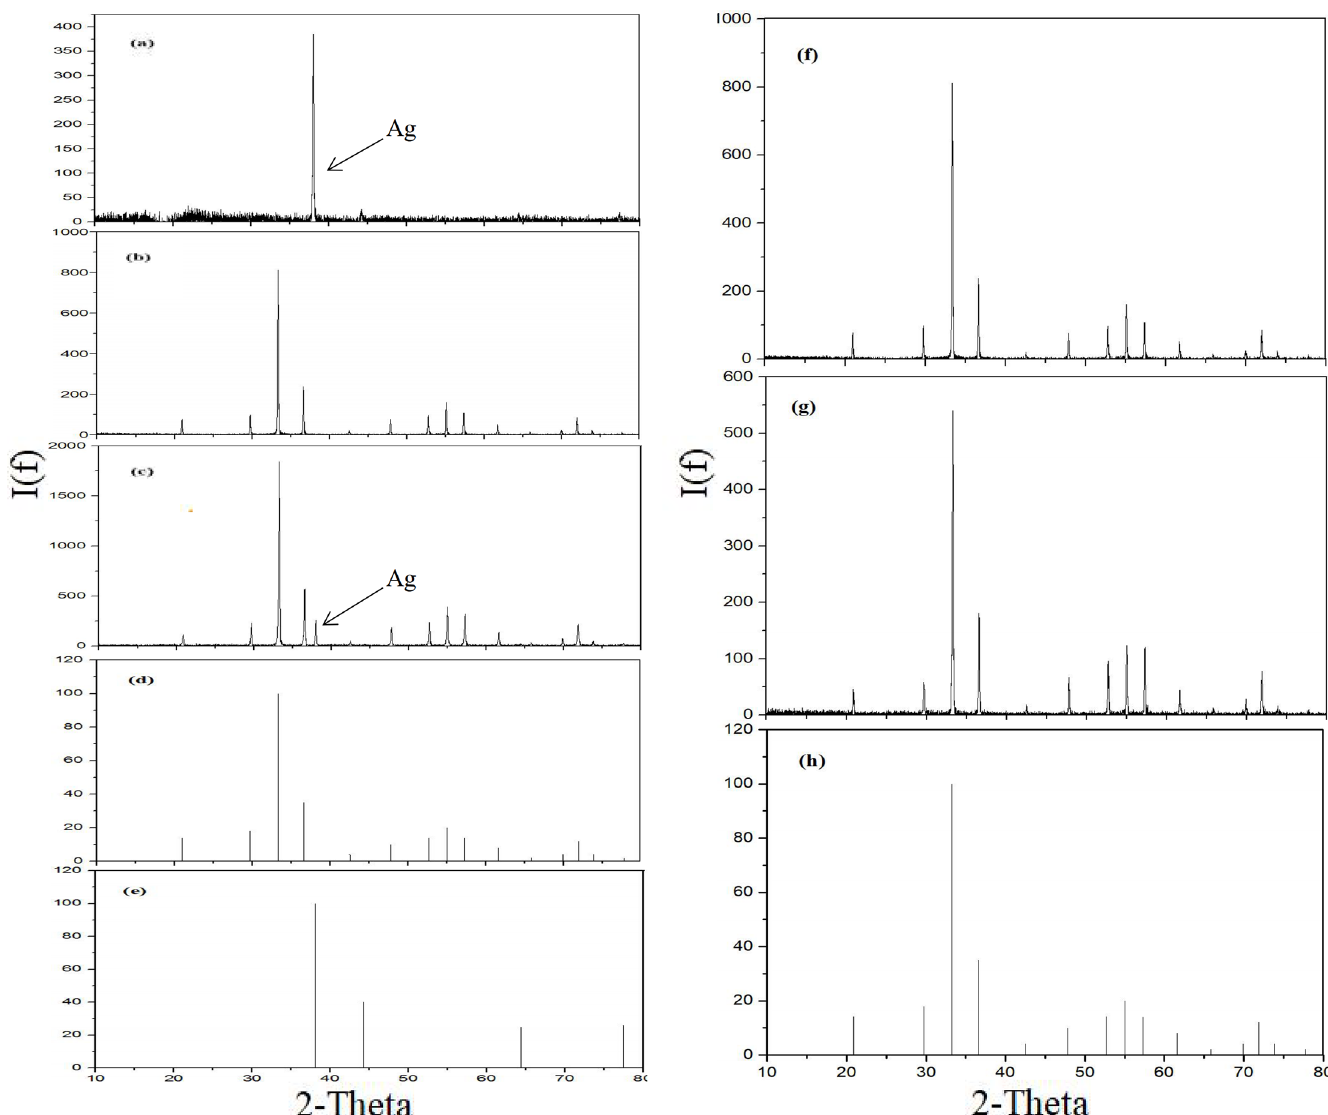
Fig 3. XRD spectrums of the silver phosphates by different treatments. The arrows in the graphs indicate the peak of the elemental silver. (a) graph showing the characteristic peak of elemental silver, which indicates that the gray and black impurity obtained by filtration is elemental silver. However, in the graph (b), the peak of the elemental silver obviously disappears; (c) graph indicating that there are obvious peaks of elemental silver in silver phosphate precipitation, which demonstrates that silver elements are mixed in silver phosphate. (a): (filtered) the gray-black impurity, (b): prepared from KH 2 PO 4 with dissolving APM by citric acid-ammonia,